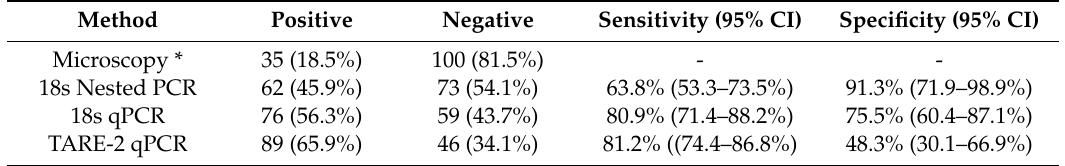
Table 1. Sensitivity and specificity table showing the percentage of positive infections detected by the di ff erent methods, sensitivity, and specificity of PCR against microscopy for the 135 samples collected from the north (sites KG and